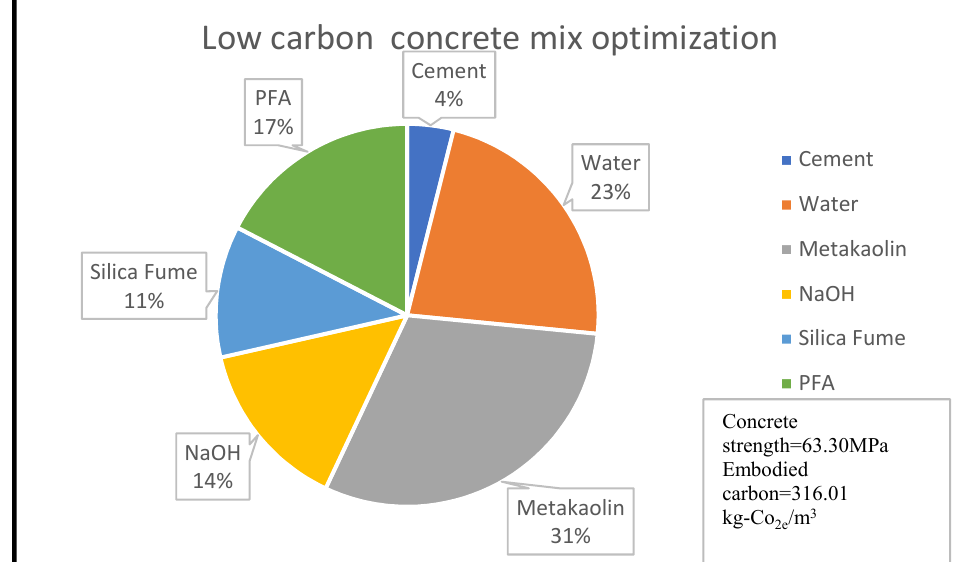
Figure 8. AAC constituent material at water content of 23% [35]. Table 17. Summary of the optimised compressive strength using the LP Table 16. Summary of the optimised Embodied Carbon using the LP Program.